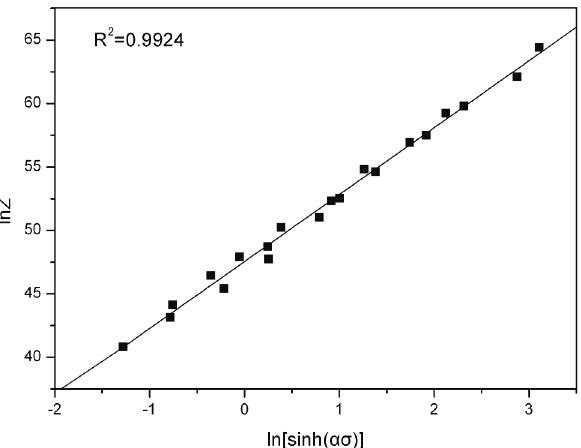
Fig. 4: Relationships between ln Z and ln[sinh( ασ )]